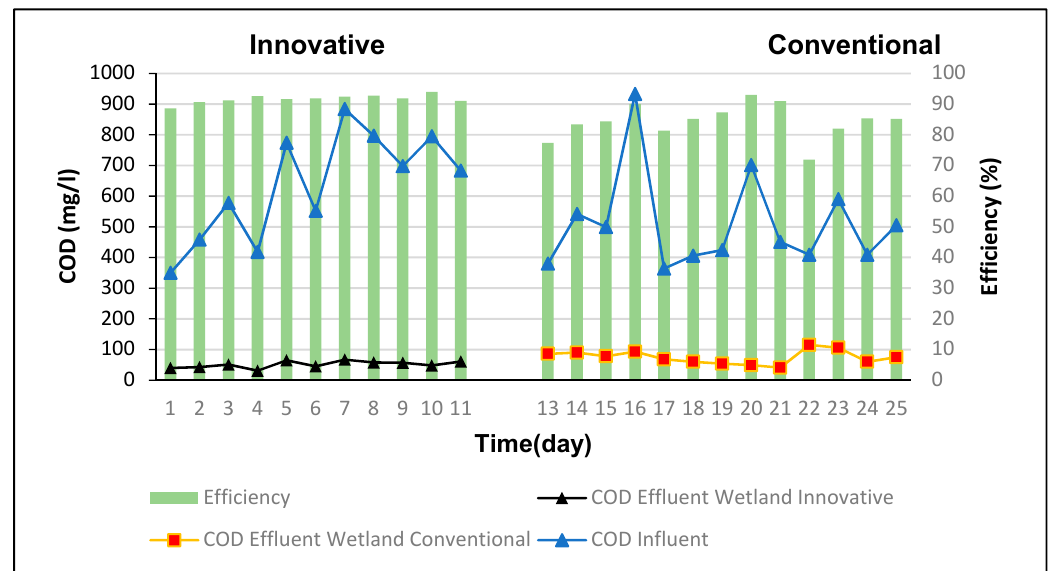
Figure 9. COD concentrations of influent and effluent in the real-scale wetland.